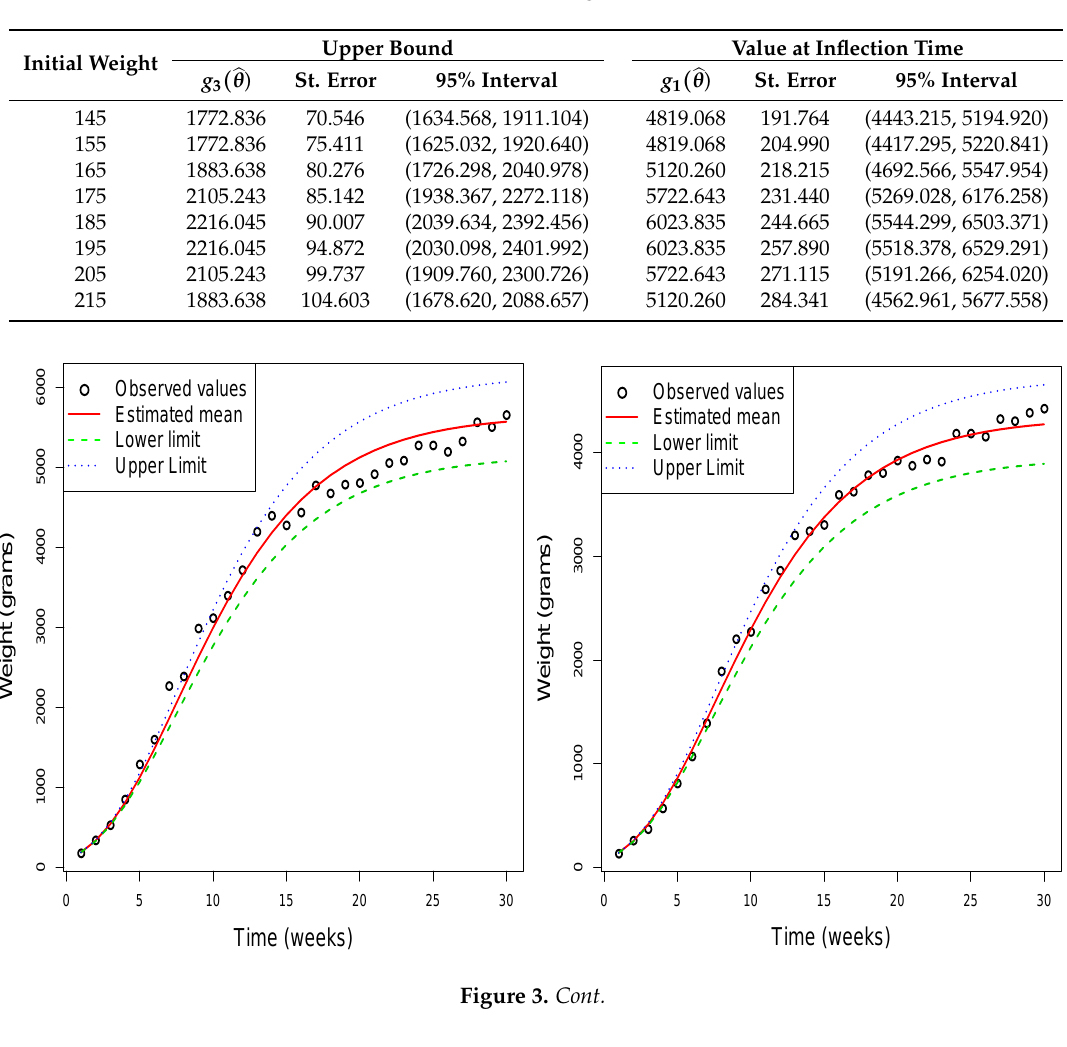
Table 3. Estimated values, standard errors, and 95% confidence intervals of the upper bound and value at the inflection time for several values of the initial weight.